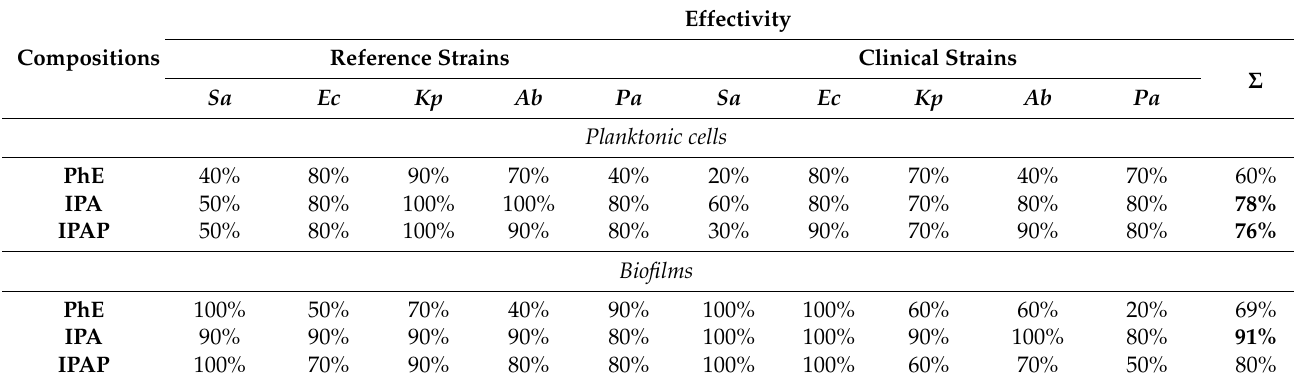
Table 6. Effectivity of antiseptic compositions.